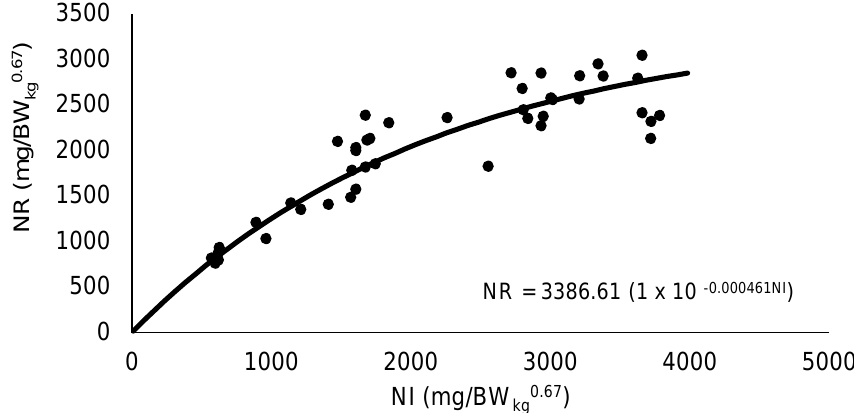
Figure 1. Estimation of the nitrogen requirements for maintenance by fitting an exponential function